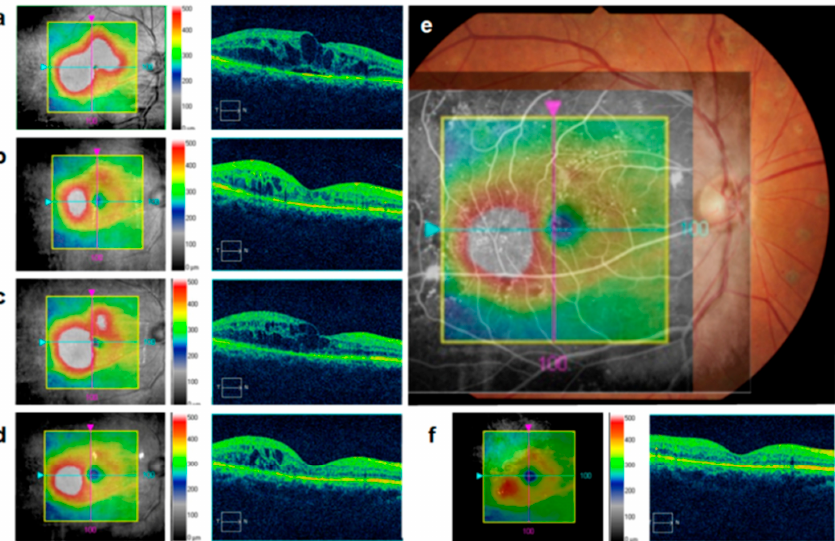
Figure 4. Microaneurysms in areas of residual edema after anti-VEGF treatment. ( a ) Optical co- herence tomography (OCT) map and cross-sectional images show a representative case of diabetic macular edema (DME) and its improvement ( b , d ) and recurrence ( c ) after anti-VEGF treatment. ( e ) Merged images show microaneurysms (MAs) in areas of residual focal edema. ( f ) After direct photocoagulation aiming MAs, focal edema improved, and recurrence was not